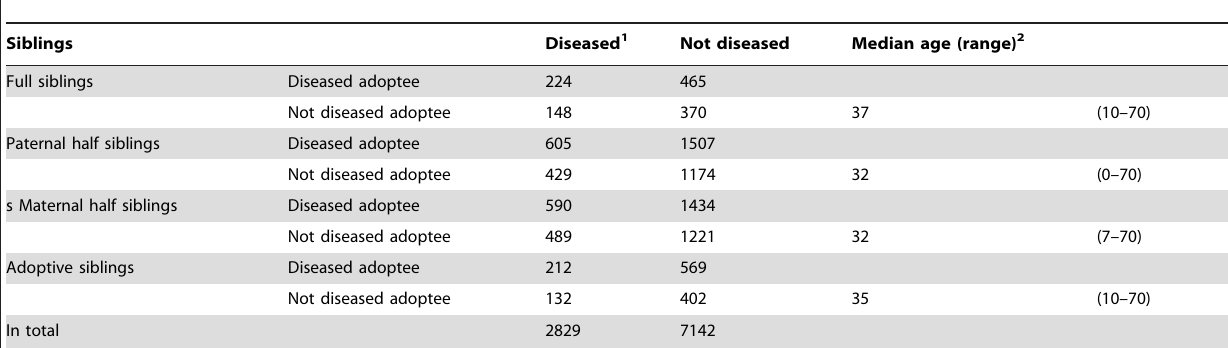
Table 1. The 9971 siblings according to their own disease status and by disease status of the adoptee (1440 diseased adoptees and 1139 not diseased